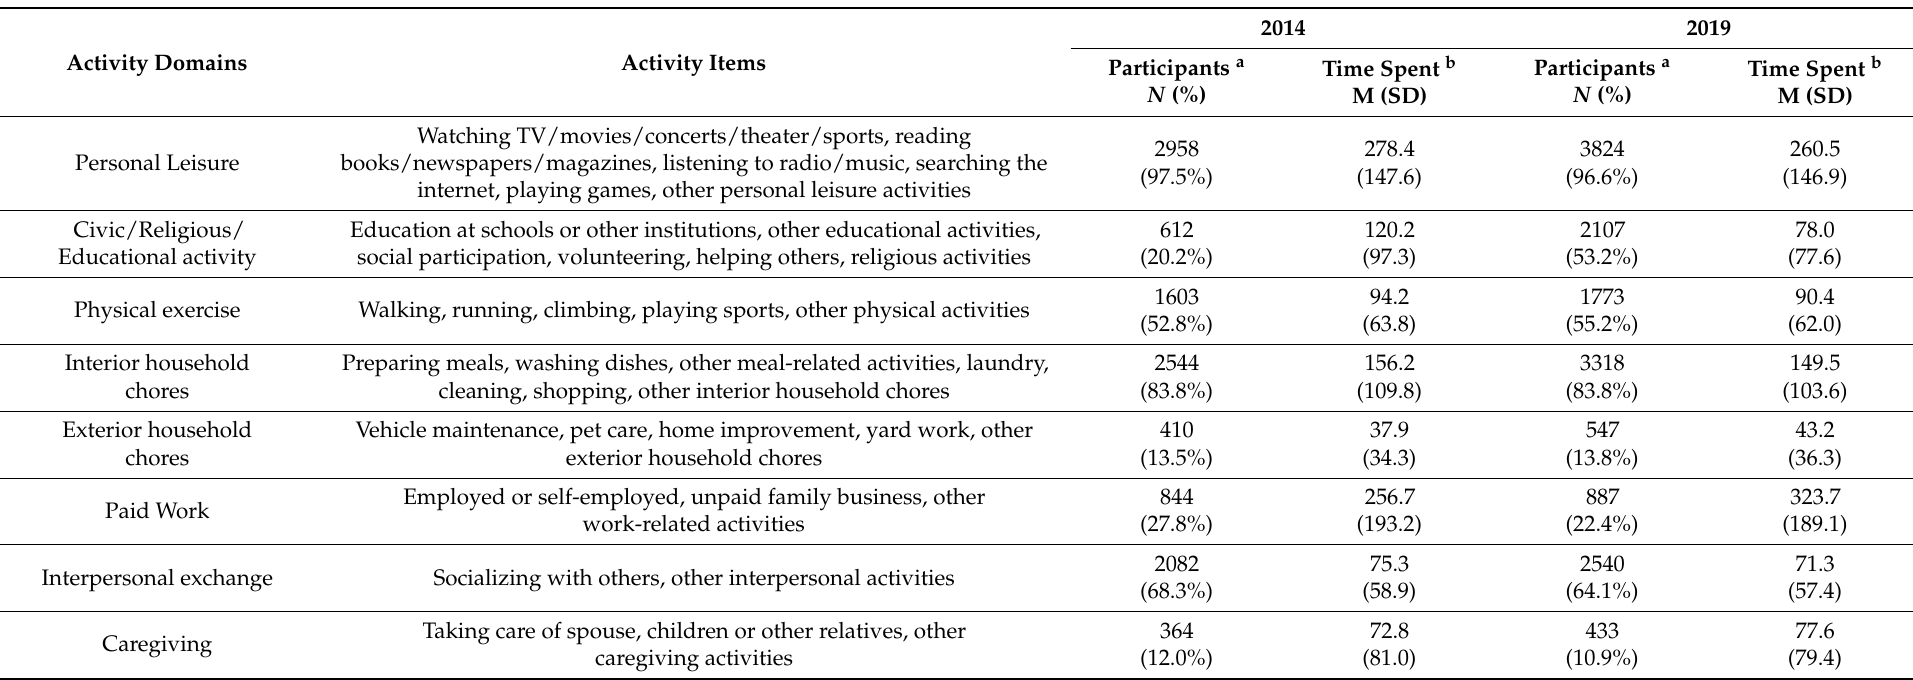
Table 1. Types and amount of activities: KTUS 2014 and